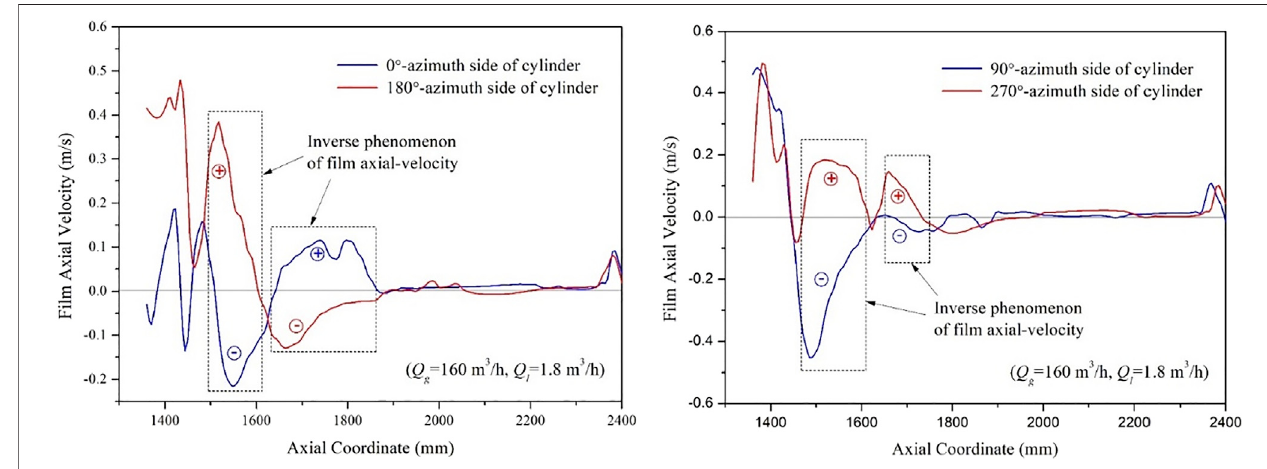
FIGURE 9 | Film Axial Velocity at four azimuth of the cylinder for the gas – liquid fl owrates of 160 – 1.8 m 3 /h.